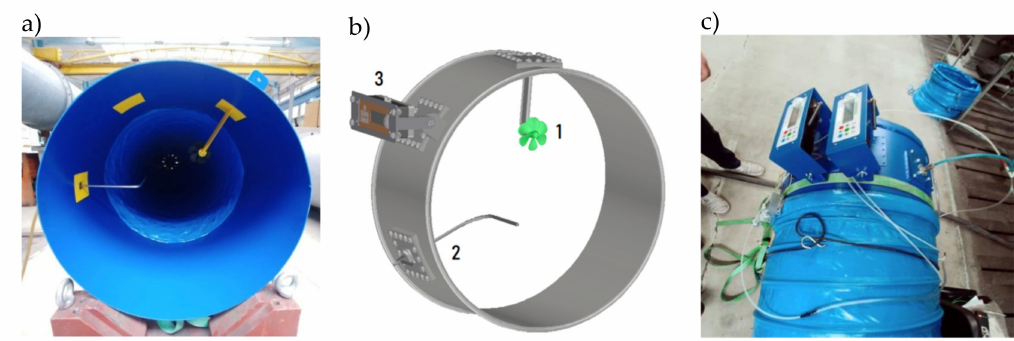
Figure 7. Measuring device installed in the connector: ( a ) view of the test model, ( b ) 3D model view (1—supplying module, 2—Prandtl probe, 3—measuring module), ( c ) view of measuring